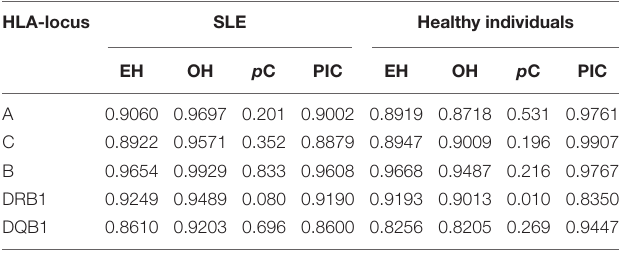
TABLE 2 | Estimations of genetic diversity of HLA class I and class II loci in SLE patients and healthy Individuals. HLA-locus SLE Healthy individuals